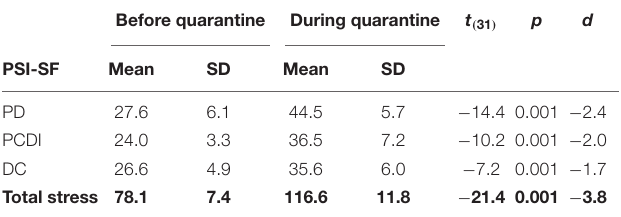
TABLE 5 | Impact of Spain’s National Quarantine on the stress of parents with a child who has dyslexia. Before quarantine During quarantine t ( 31